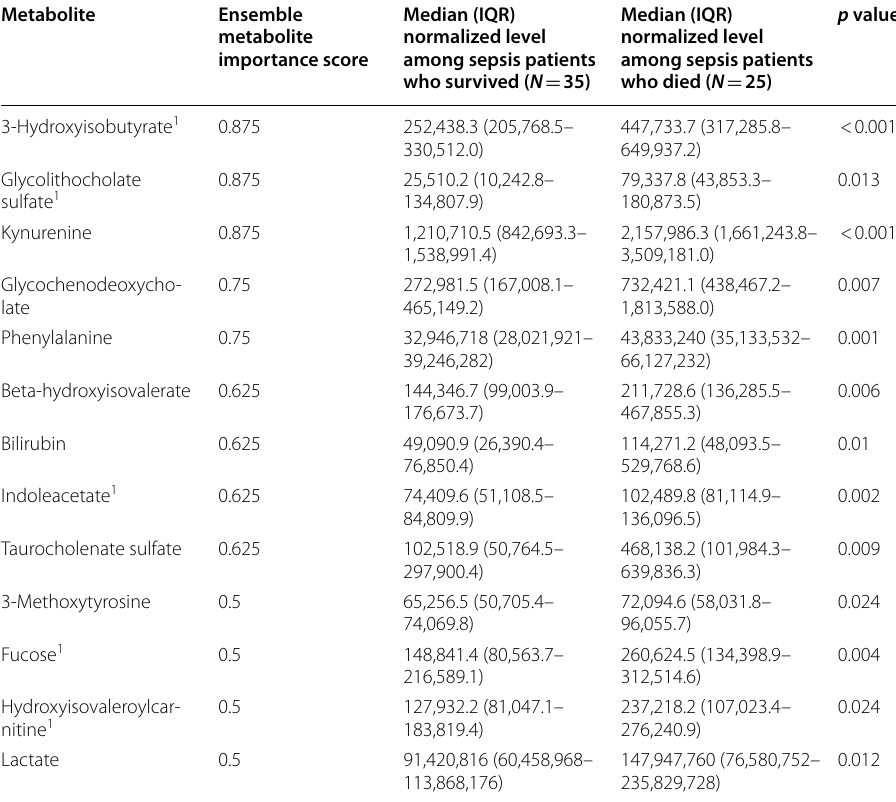
Table 2 Top‑ranked metabolites linked with survival ranked by ensemble machine learning‑derived summary importance score (defined as those with importance score median (interquartile range) normalized levels among septic patients who survived ( N those who died ( N =